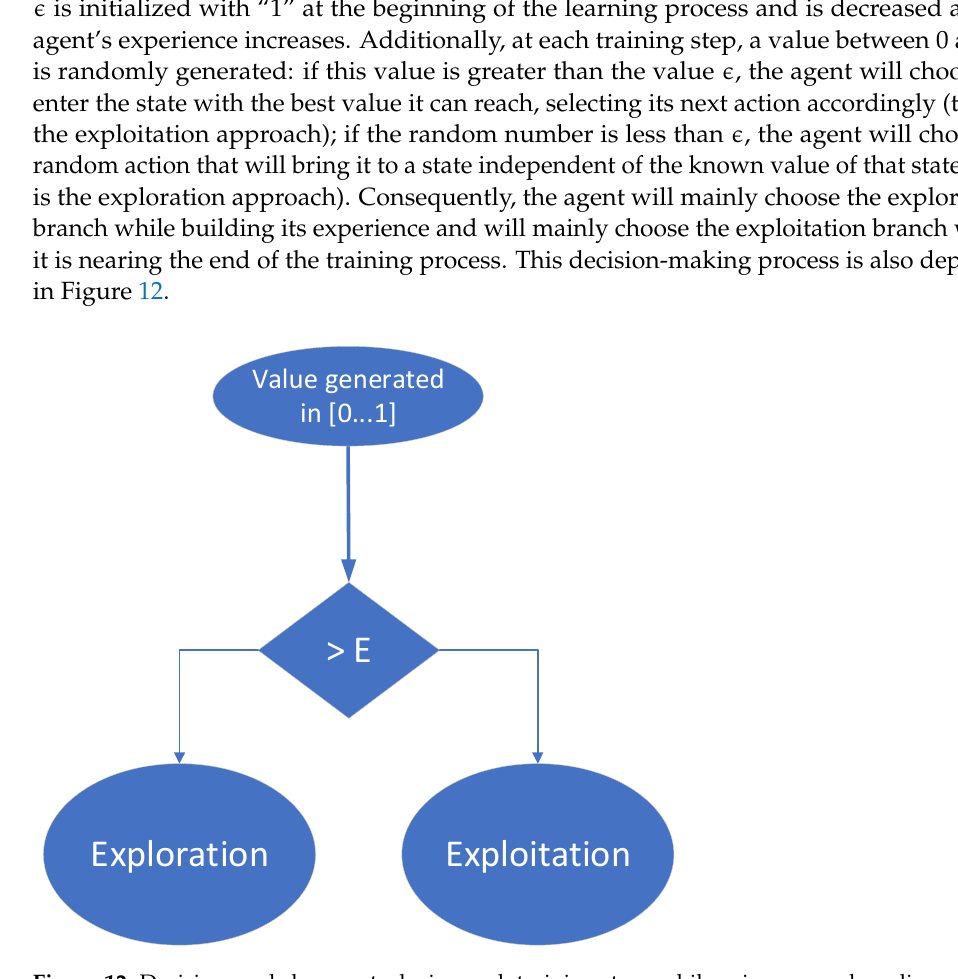
Figure 12. Decision made by agents during each training stage while using ϵ -greedy policy. In the current implementation, ϵ is initialized with “1” at the beginning of the training process. During the training process, ϵ is decremented (1) either at the end of each training episode or (2) each time the agent enters the exploration branch.